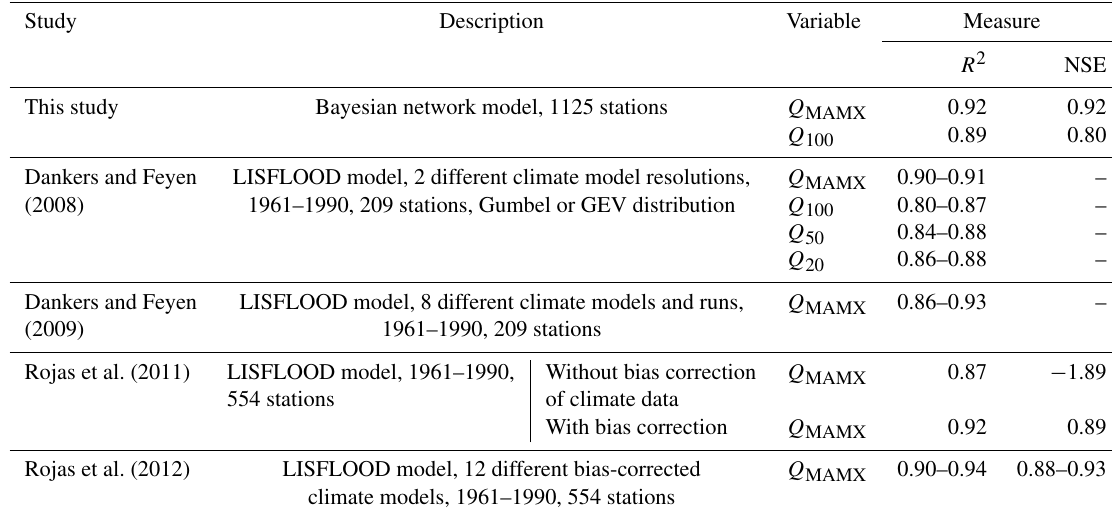
Table 4. Reported validation results for extreme discharge simulations for